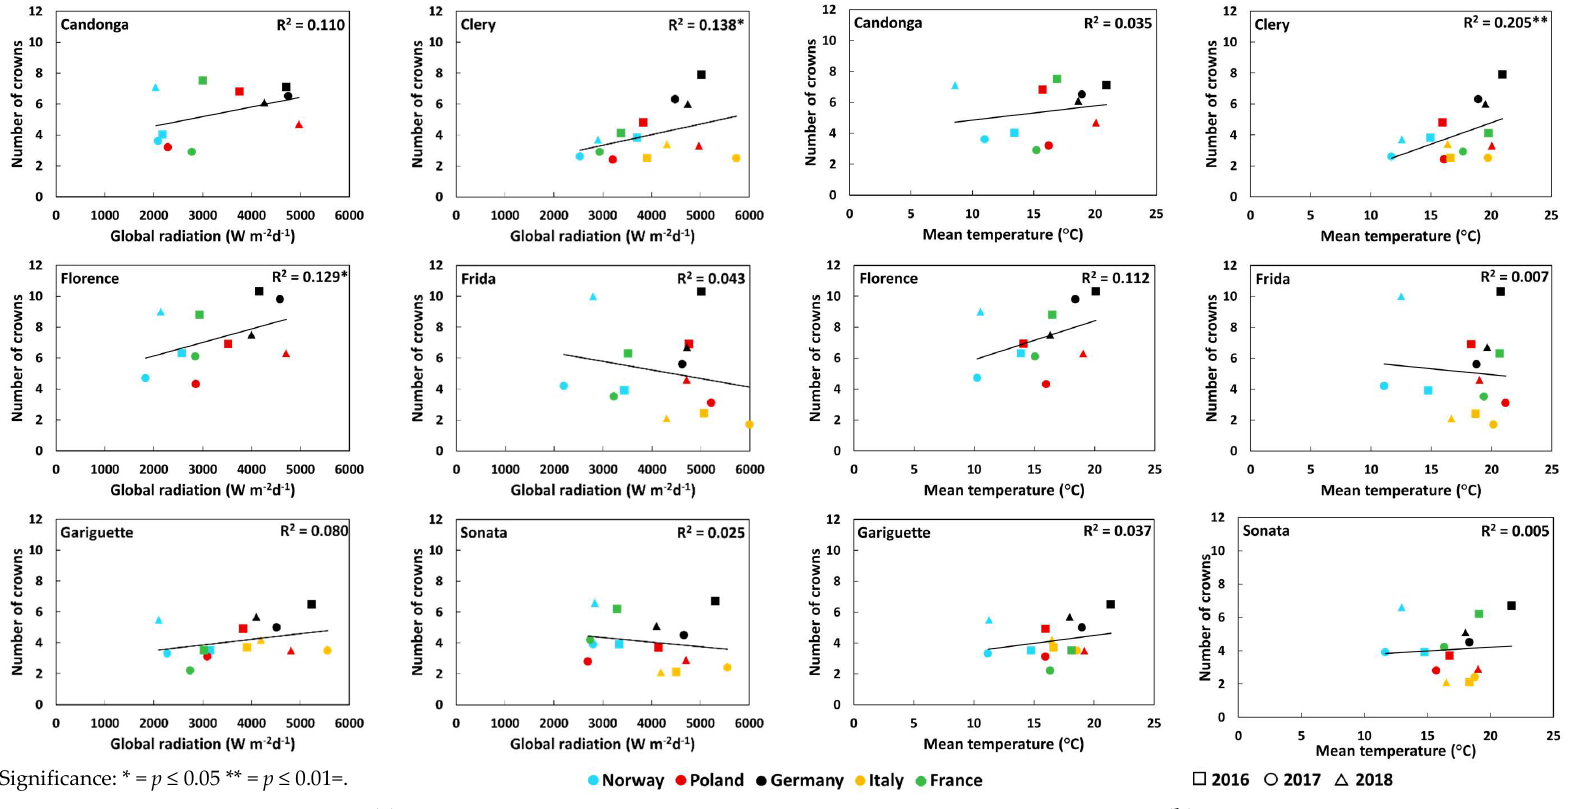
Figure 5. Number of crowns of six cultivars grown at five locations in Europe as influenced by ( a ) global radiation and ( b ) mean temperature during the 3-week period preceding flower initiation in three years.